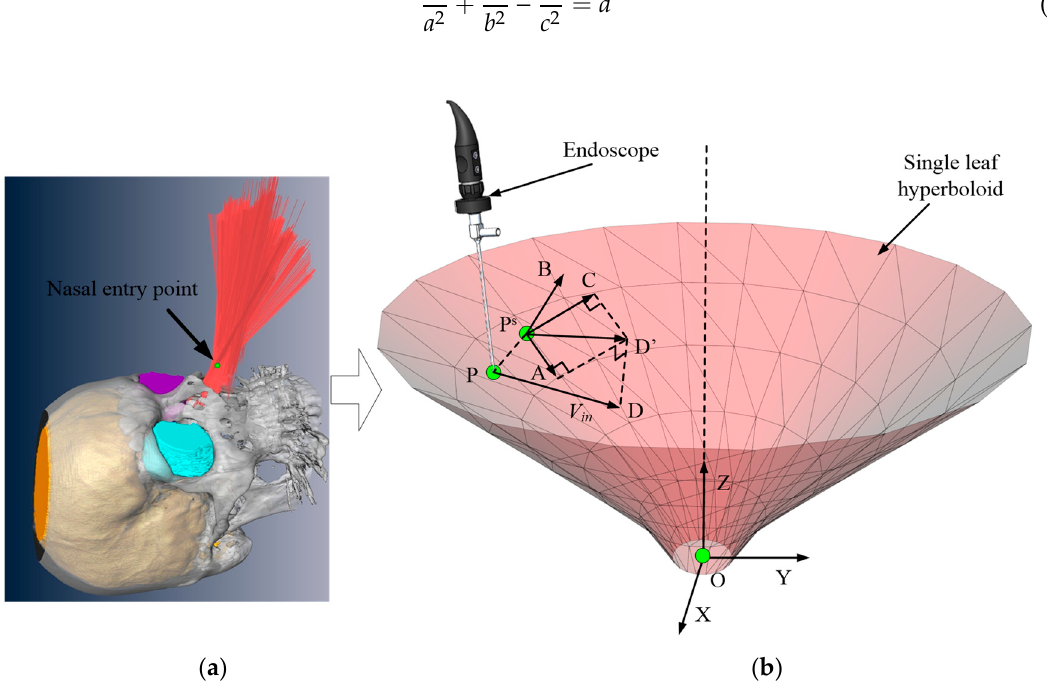
Figure 3. Schematic diagram of the FRVF based on a single-leaf hyperboloid. ( a ) The funnel-shaped endoscope workspace, ( b ) the FRVF based on a single-leaf hyperboloid.